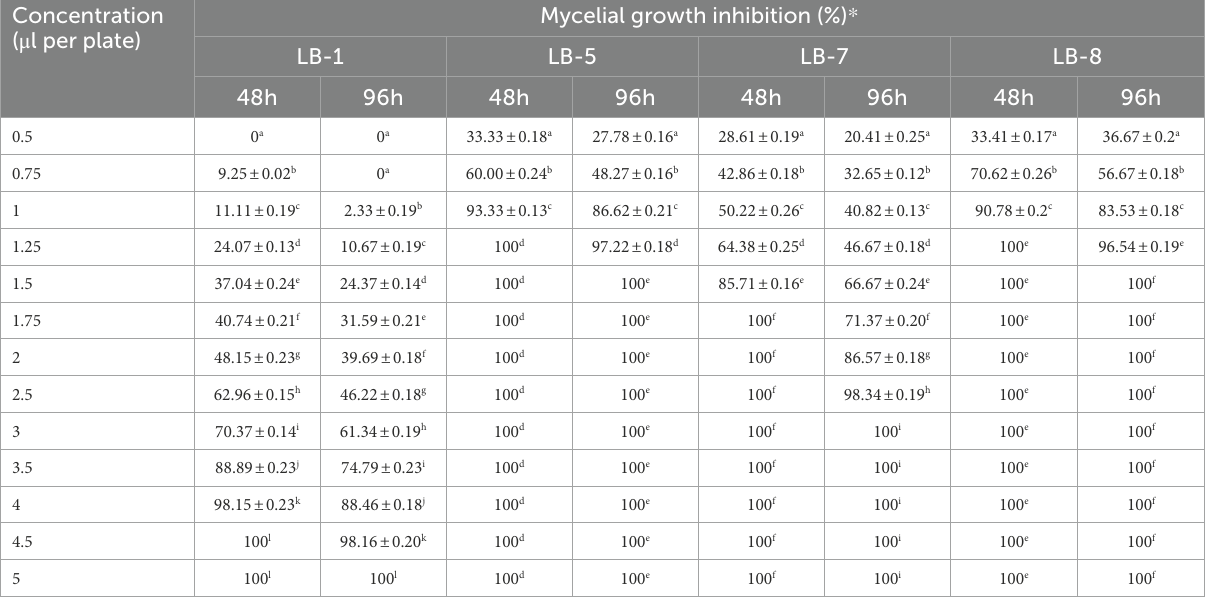
TABLE 1 Minimum inhibitory concentration and minimum fungicidal concentration of 2,3-butanedione against pathogenic fungus. Concentration ( μ l per